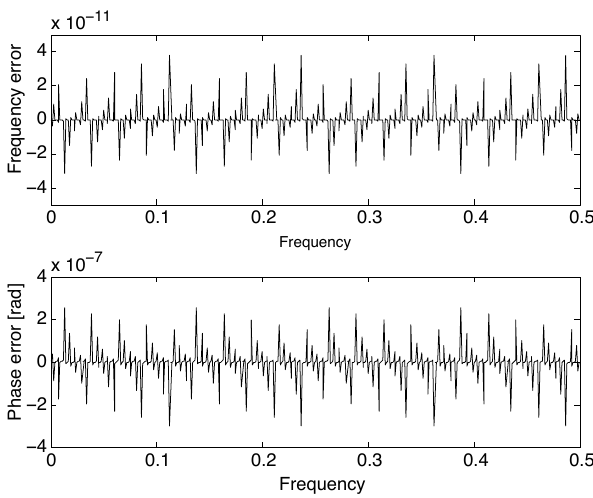
Fig. A1. Errors of frequency (top) and phase (bottom) determina- tion for pulses with different frequencies. The pulse length is 1920 samples and the length of Fourier transform is 2 13 points. A sin- gle phase value of π/ 3 is used in all cases and the error correction method is applied.